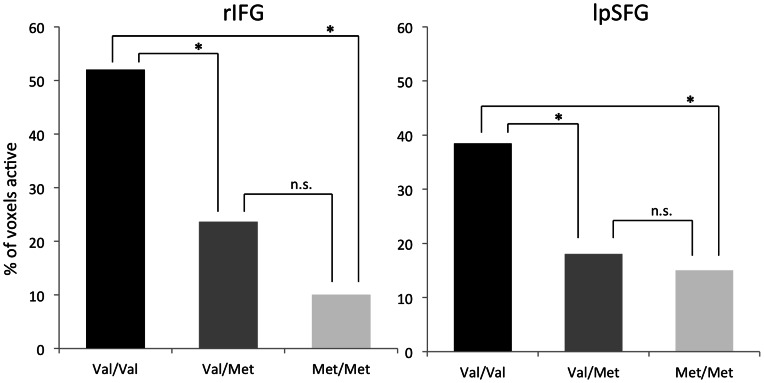
Genotype-dependent [18F]fallypride displacement in response to psychosocial stress.Comparison of the spatial extent to which [18F]fallypride displacement could be observed in VOIs, using parametric maps. Val-homozygotes showed the greatest difference in % of voxels active in response to stress per VOI (reflecting increased [18F]fallypride displacement), followed by Met-hetero- and homozygotes. The % of voxels active per VOI was not significantly different for Met-hetero- and homozygotes. Depicted numbers represent % of voxels active associated with stress (condition). Val/Met and Met/Met genotype are depicted separately to visualize the direction of the effect, but were grouped for the analyses. * = Exceeding threshold of p(corrected)<.05; n.s. = not significant. Note that the depicted % indicate the spatial extent to which ligand displacement was detected yet the % do not indicate VOI activity as a whole.